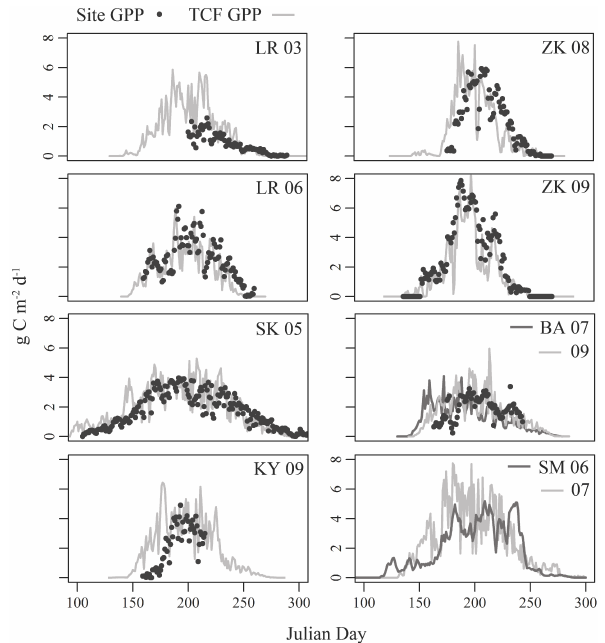
Fig. 2. TCF model simulations for GPP (lines) using input remote sensing and reanalysis information as compared with flux tower EC records (circles). Site GPP records were not available for SM and BA 2009.